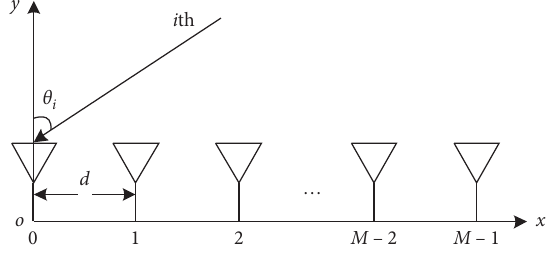
Figure 1: Uniform linear antenna array for signal